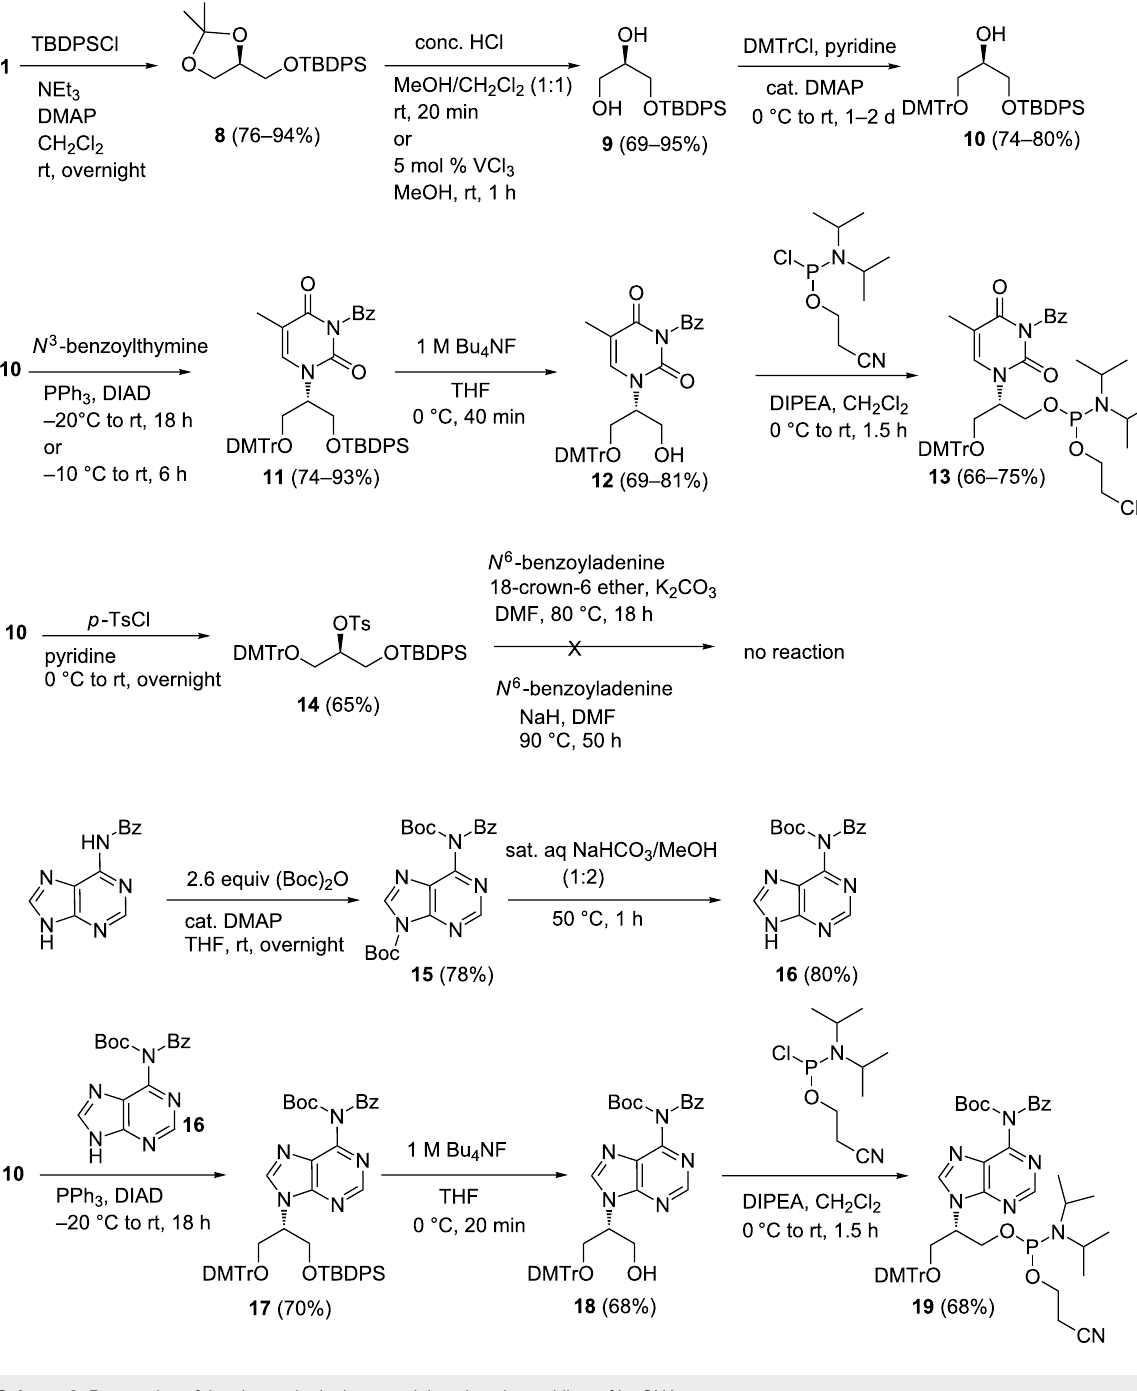
Scheme 2: Preparation of thymine and adenine containing phosphoramidites of isoGNA.